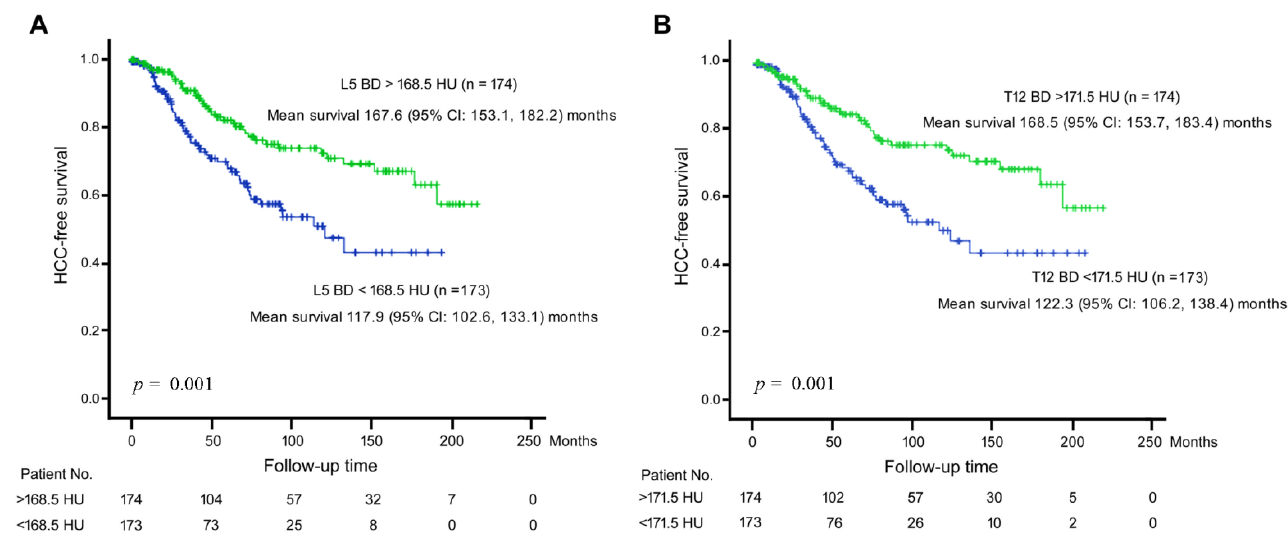
Figure 1. Kaplan-Meier analysis for BD in association with time-to-HCC development. ( A ) BD as- sessed by HU at L5 area. The median HU value (168.5 HU) was used as a cutoff. Green line, L5 BD > 168.5 HU; Blue line, L5 BD < 168.5 HU. ( B ) BD assessed by HU at T12 area. The median HU value (171.5 HU) was used as a cutoff. Green line, T12 BD > 171.5 HU; Blue line, L5 BD < 171.5 HU. Ver- tical axis, HCC-free survival rate; Horizontal axis, follow-up time